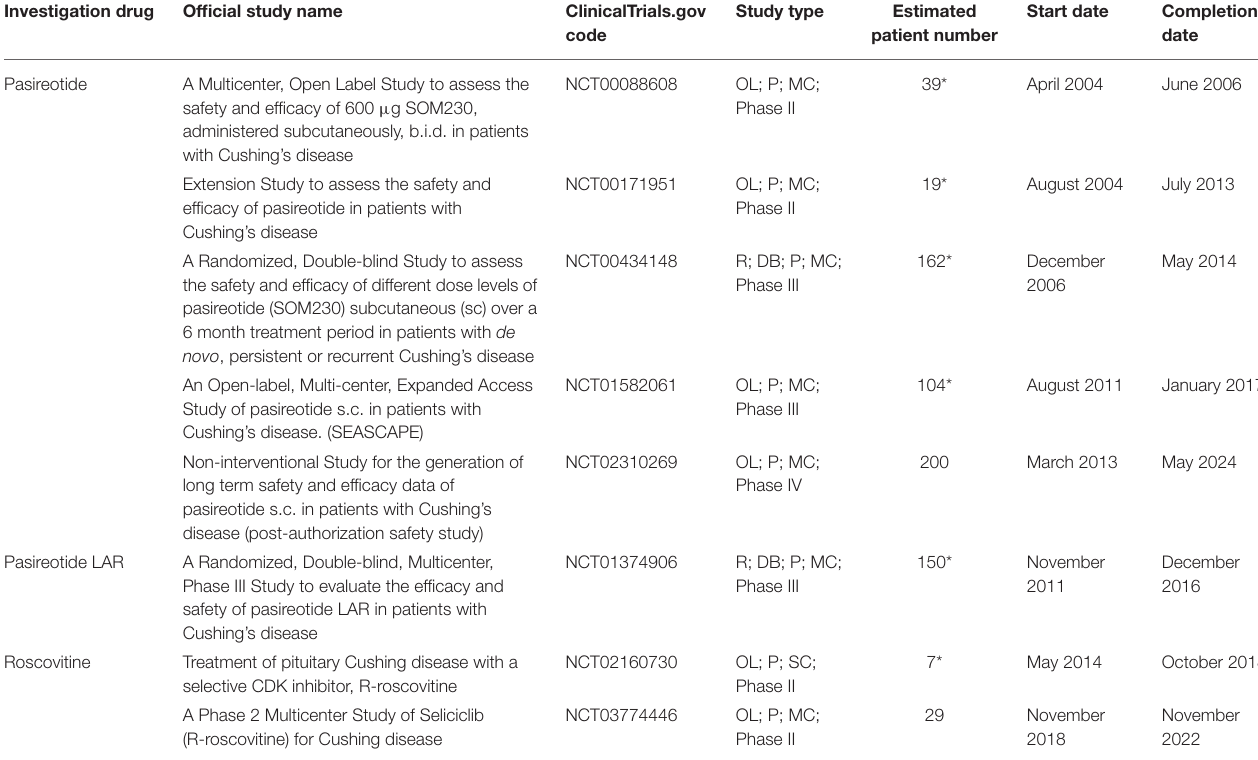
TABLE 2 | Characteristics of current and recent clinical trials, registered in clinicaltrials.gov, on pituitary-directed drugs for the treatment of Cushing’s disease in terms of official study name, identification code, study design, patient number, start, and completion